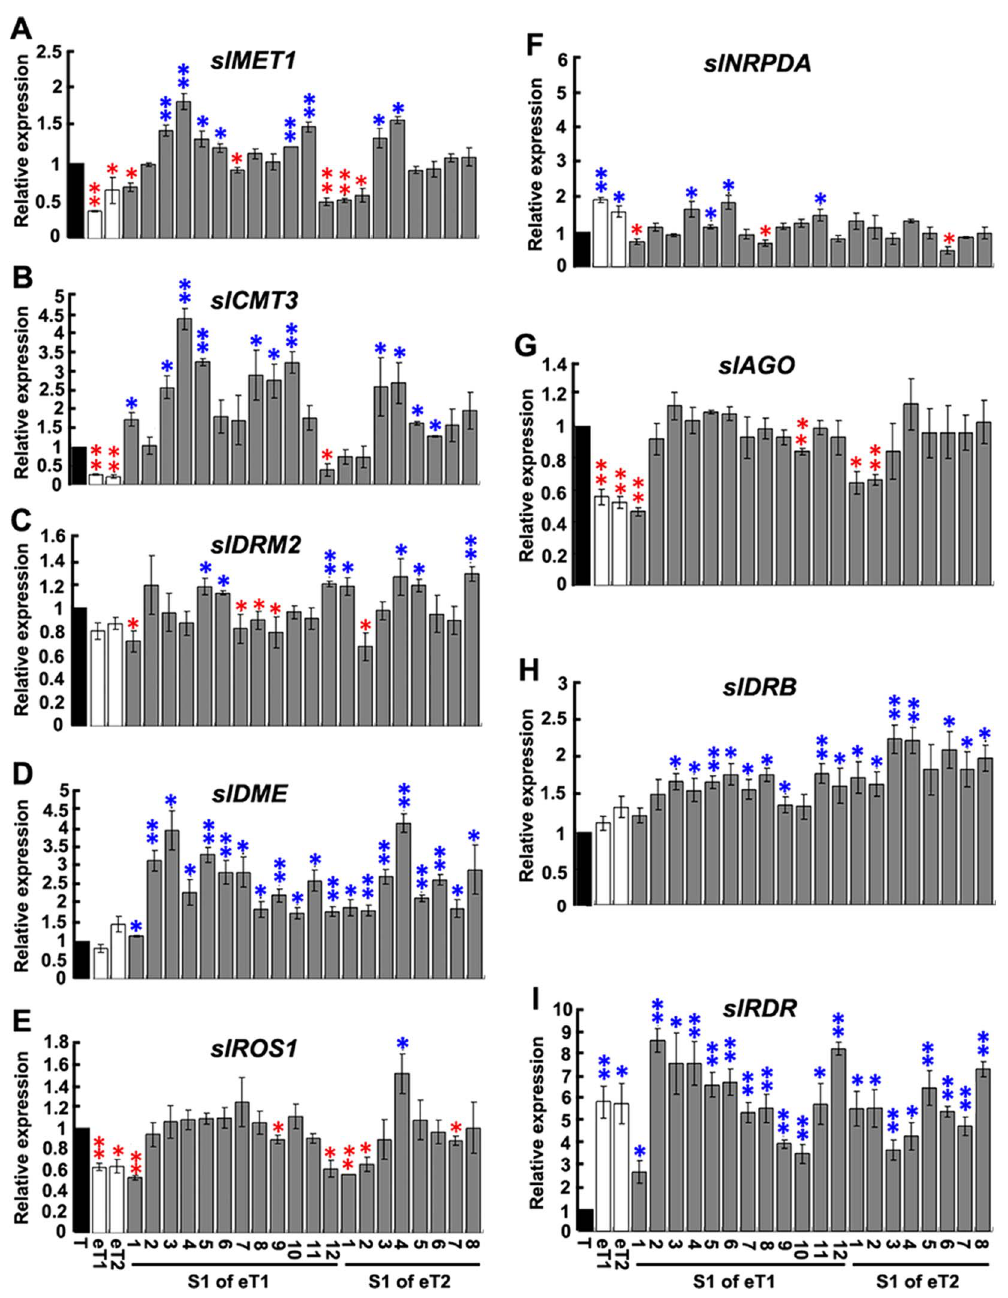
Figure 4. Real-time qRT-PCR analysis of genes encoding for enzymes involved in establishing and/or maintaining of DNA methylation. The steady-state transcript abundance of genes encoding three DNA methyltransferases, slMET1 (A), slCMT3 (B), and slDRM2 (C), two 5-methylcytosine DNA glycosylases, slDME (D) and slROS1 (E), and four proteins involved in the biogenesis of siRNAs participating in the RdDM pathway, slNRPDA (F), slAGO (G), slDRB (H), and slRDR (I) were analyzed by real-time qRT-PCR. All these genes were identified from the tomato genome (details are given in Table S1). Reverse transcription was performed on three batches of independently isolated RNAs from young leaves of the seed-plant control (T), two independent hetero-grafted (tomato to eggplant) scion plants (eT1-2), and 12 and eight selfed progeny plants (S1) of each mother scion plant. A conserved Solanaceae actin gene (Genbank accession: U60481) was used as an internal control for RNA input and DNA contamination (on RNAs without reverse transcriptase). Asterisks denote statistical difference in the transcript abundance relative to that of the corresponding seed-plant control, based on t-test at P =0.05 (*) and P =0.01 (**) levels, respectively. Colors of asterisks refer to significant up- (blue) and down-regulation (red), respectively. required for DNA methylation, which warrants further investiga- tions that may entail the employment of various mutants for each and combinations of these chromatin-regulation genes.